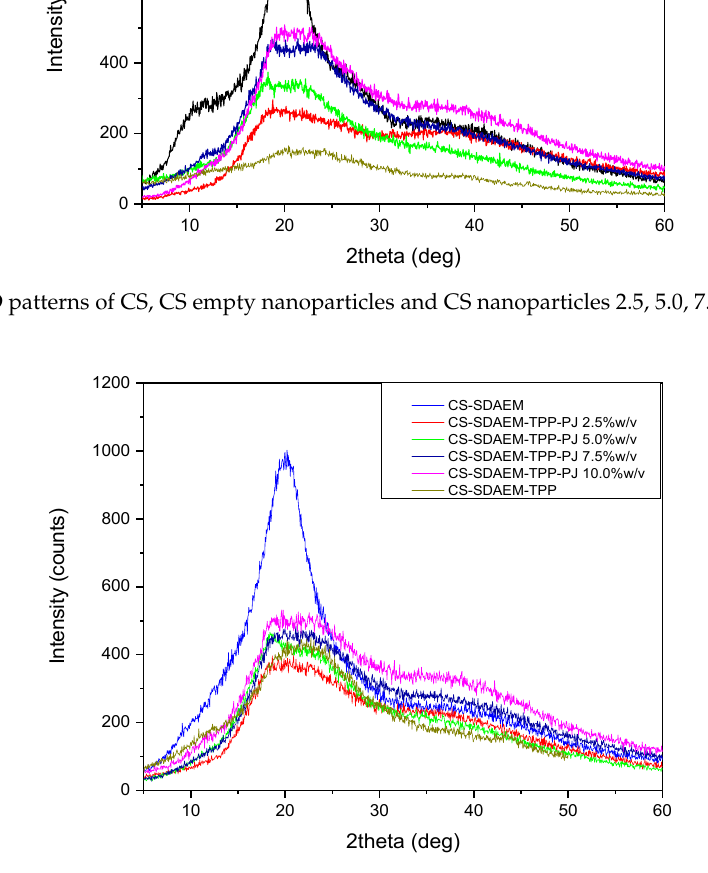
Figure 9. XRD patterns of CS-SDAEM, CS-SDAEM empty nanoparticles and CS-SDAEM nanoparticles 2.5, 5.0, 7.5 and 10.0 wt% containing